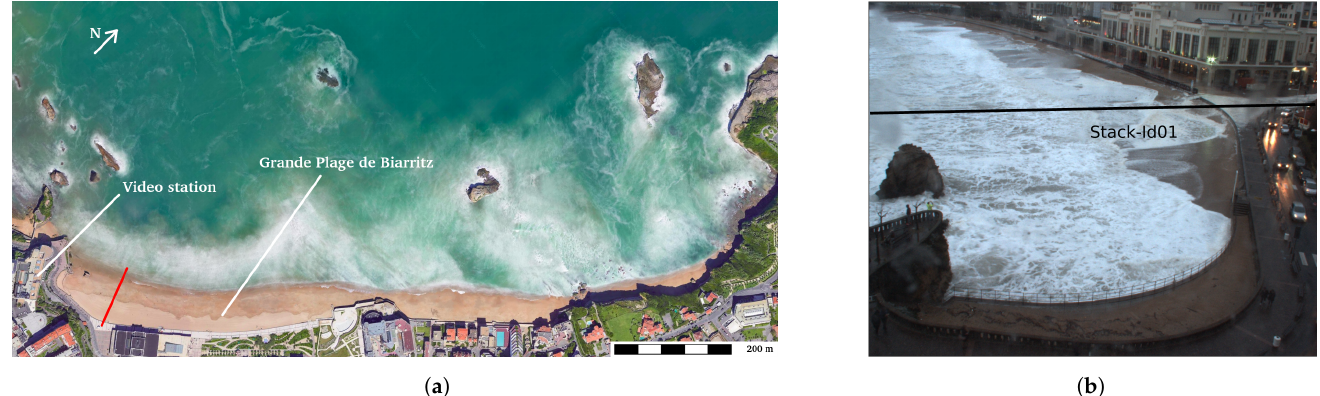
Figure 3. ( a ) Satellite view of the site of Biarritz from Google Earth with red lines representing the transects on the site. ( b ) Transect on the Grande Plage de